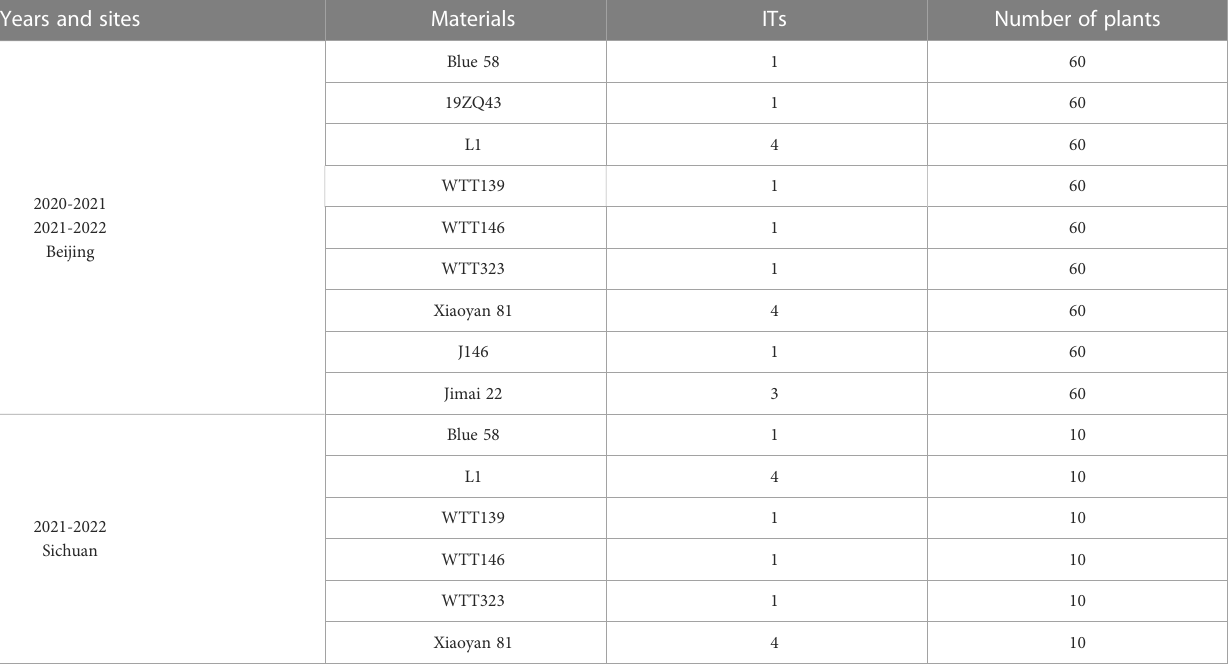
TABLE 1 Powdery mildew resistance assessment of Blue 58, its derived lines, Xiaoyan 81 and Jimai 22.